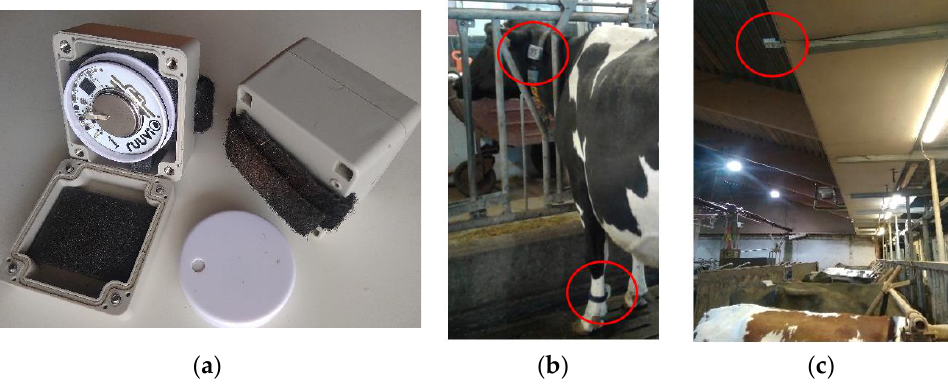
Figure 2. Component of the location and acceleration measuring system installed in a barn: RuuviTag inside a protecting plastic box ( a ), tag on the cow collar ( b ) and receiving station installed on a barn structure ( c ) marked by red circles.